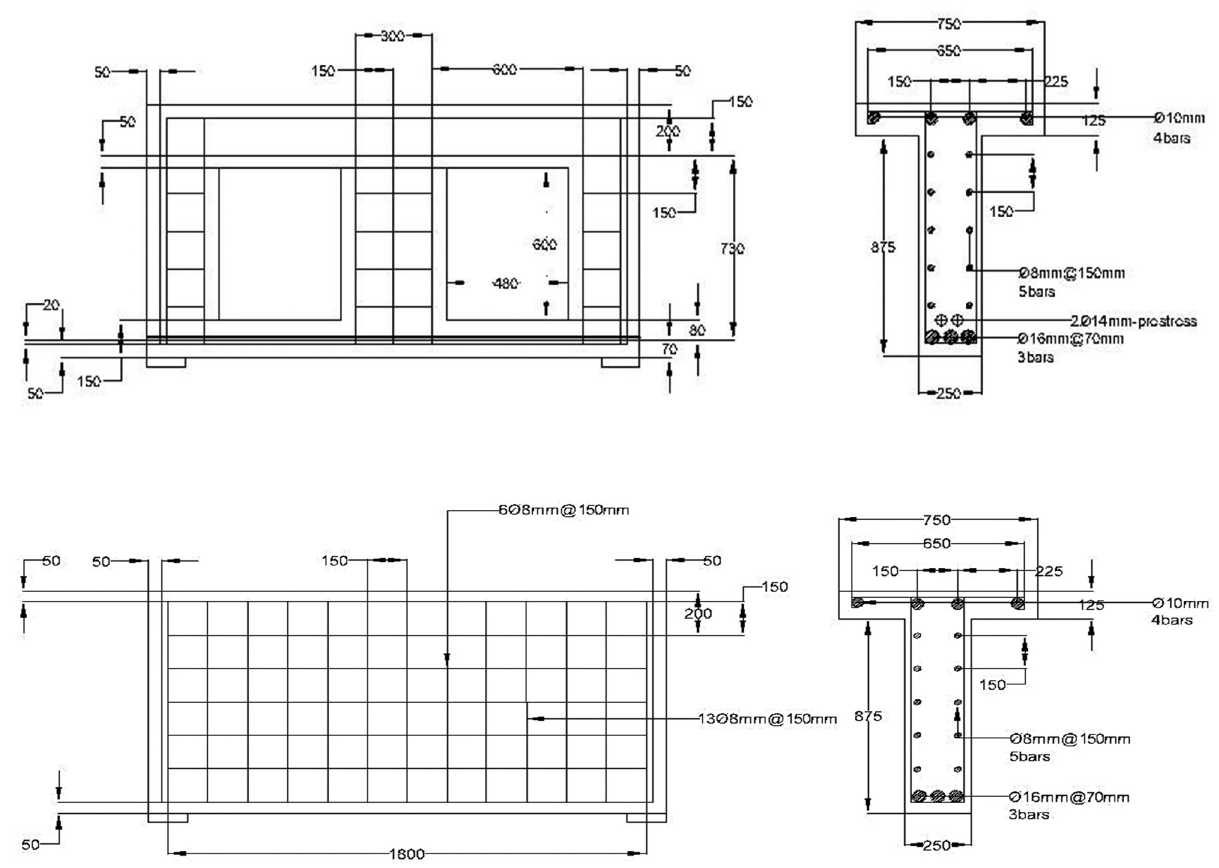
Figure 1: Cross - section, details, and reinforcement of tested deep